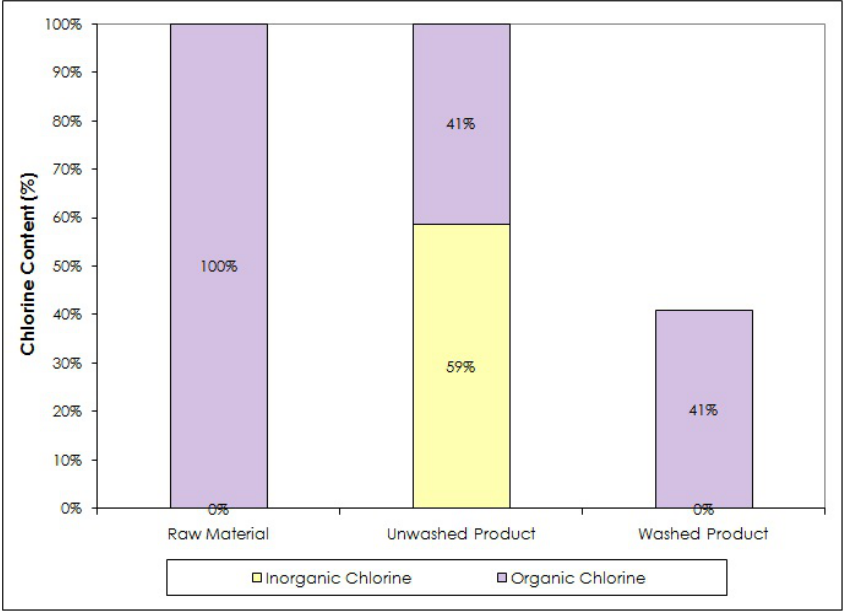
Figure 8. Chlorine contents of the raw material and the hydrothermal products before and after the washing process (KOH-added PVC).